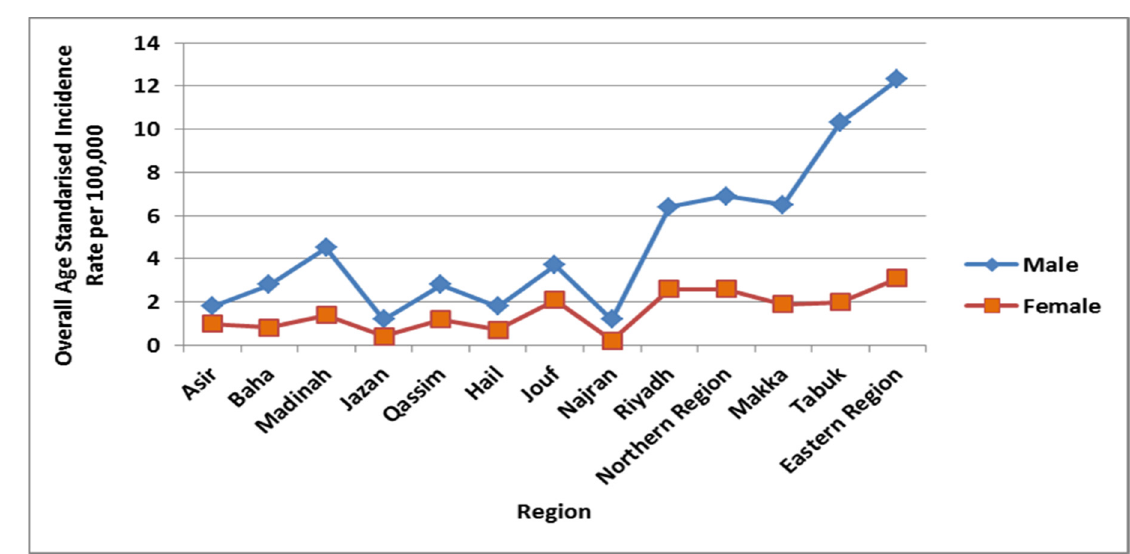
Figure 7. A: Overall ASIR of lung cancer cases per 100,000 among males and females according to administrative regions during 2006 to 2016.